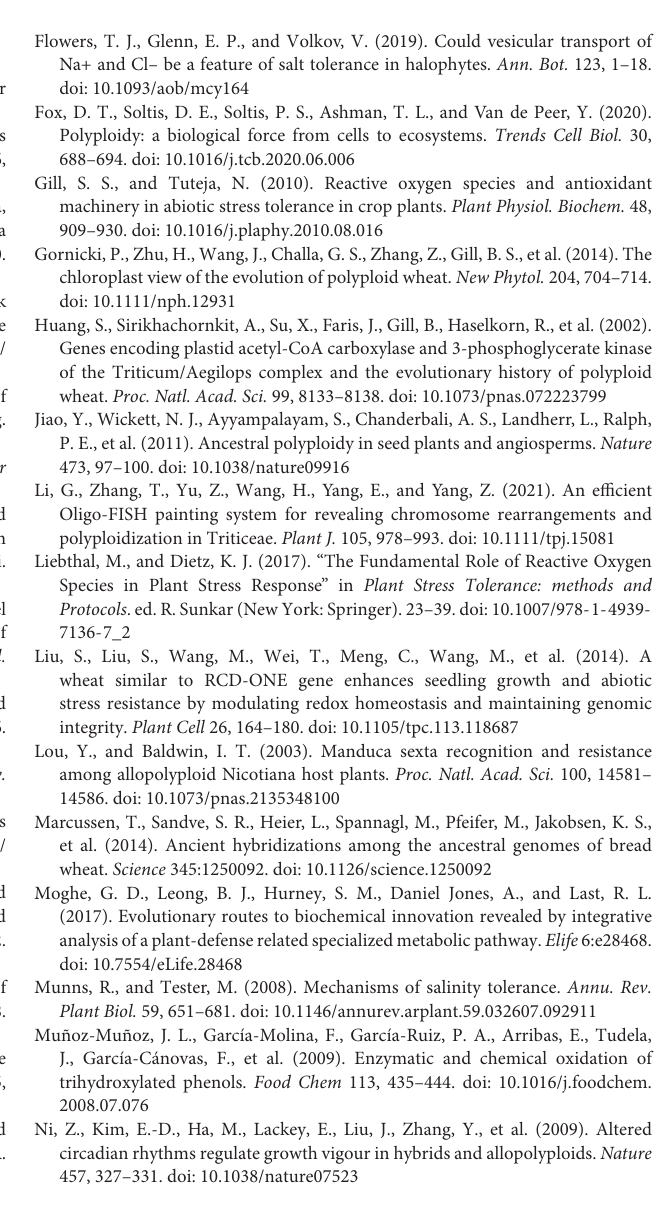
and its parents. and its parents. value generated indicate larger variation caused by species, stress treatment, or their